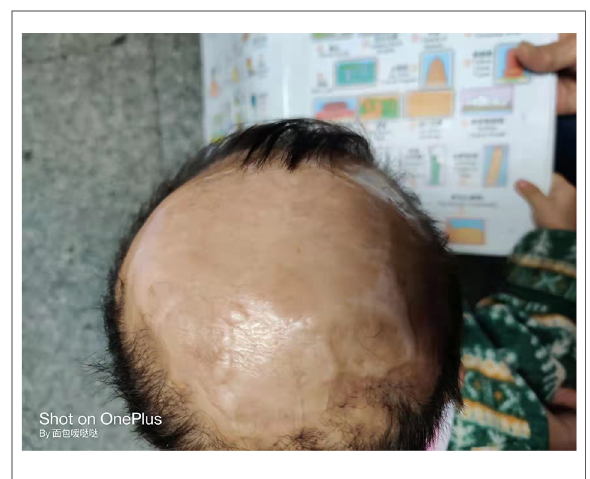
FIGURE 3 The scalp of the patient with aplasia cutis congenita at 2 years